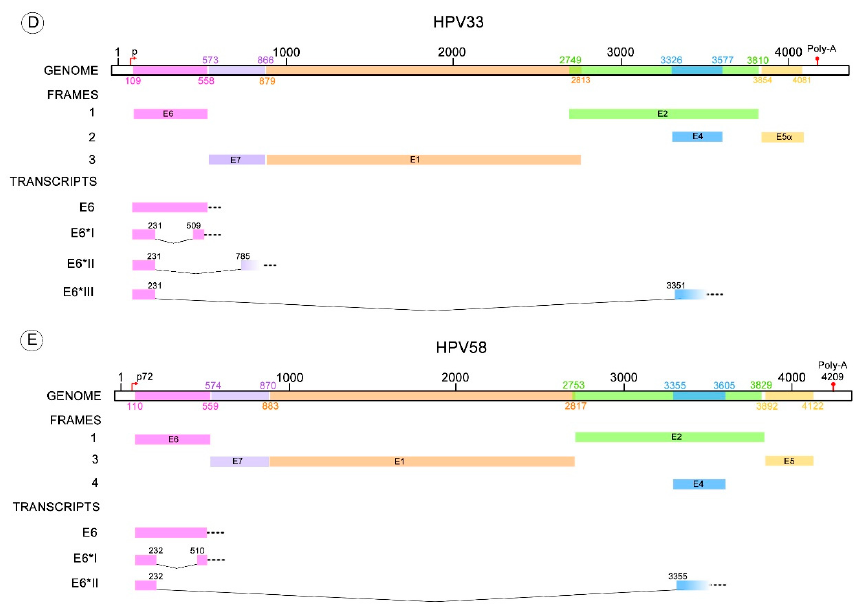
Figure 3. HR-HPV E6 alternative RNA splicing. The donor and acceptor splicing sites for the E6 truncated transcripts of different HPV types that possess more than one variant of E6* mRNA. ( A ) The E6* transcripts identified in HPV16 are E6*I to VI, E6ˆE7, E6ˆE7*I and E6ˆE7*II; ( B ) Four E6* transcripts have been described for HPV18 termed E6*I to III and E6ˆE7; ( C ) E6*I and E6ˆE4 transcripts are known for HPV31; ( D ) E6*I to III for HPV33; ( E ) E6*I and II transcripts for HPV58. All these transcript variants contain a donor splicing site within the E6 open reading frame (ORF), while the acceptor splicing site is contained through the early HPV pre-mRNA (E6, E7, E2 or E4 ORFs). The nucleotide positions of early promoters (p) and early polyadenylation (Poly-A) sequences, as well as the positions of early genes, were obtained from Papillomavirus episteme [8]. The early promoter of HPV58 was obtained from Li Y. et al. 2013 [67]. All the donor and acceptor splicing sites are listed in Table